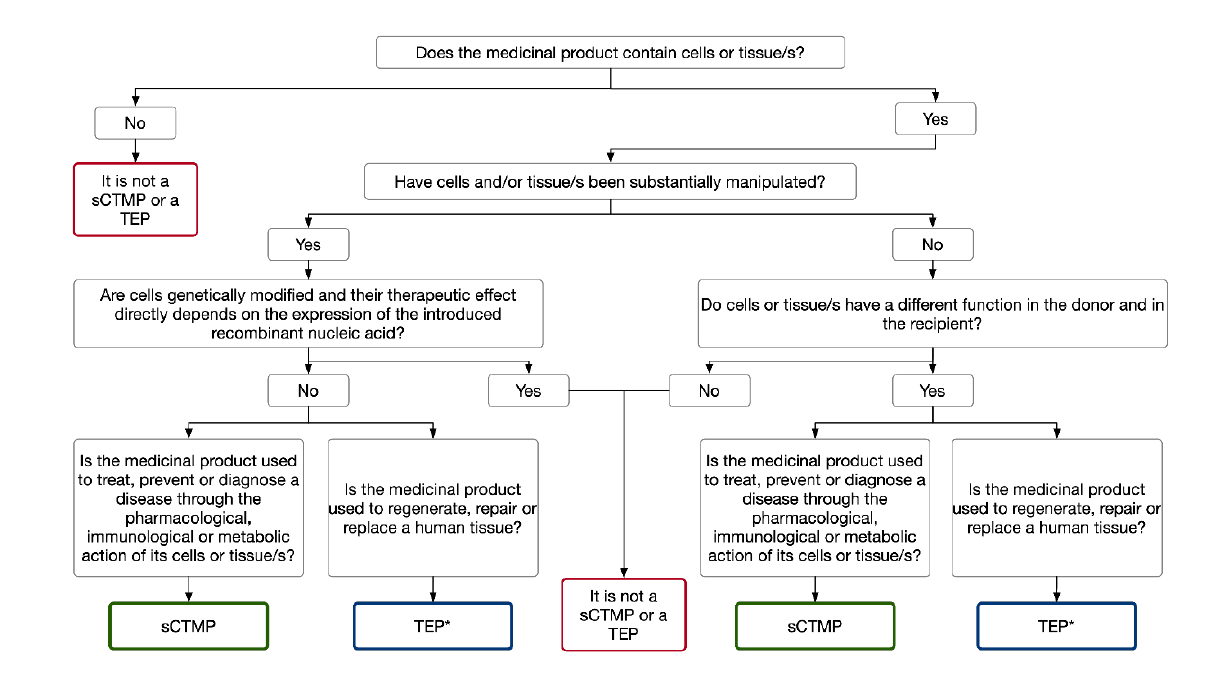
Figure 2. Easy guide to classify a cell-based medicinal product as a sCTMP or a TEP. Abbreviations: sCTMPs, somatic cell therapy medicinal products; TEPs, tissue engineered products. Modified from [14].